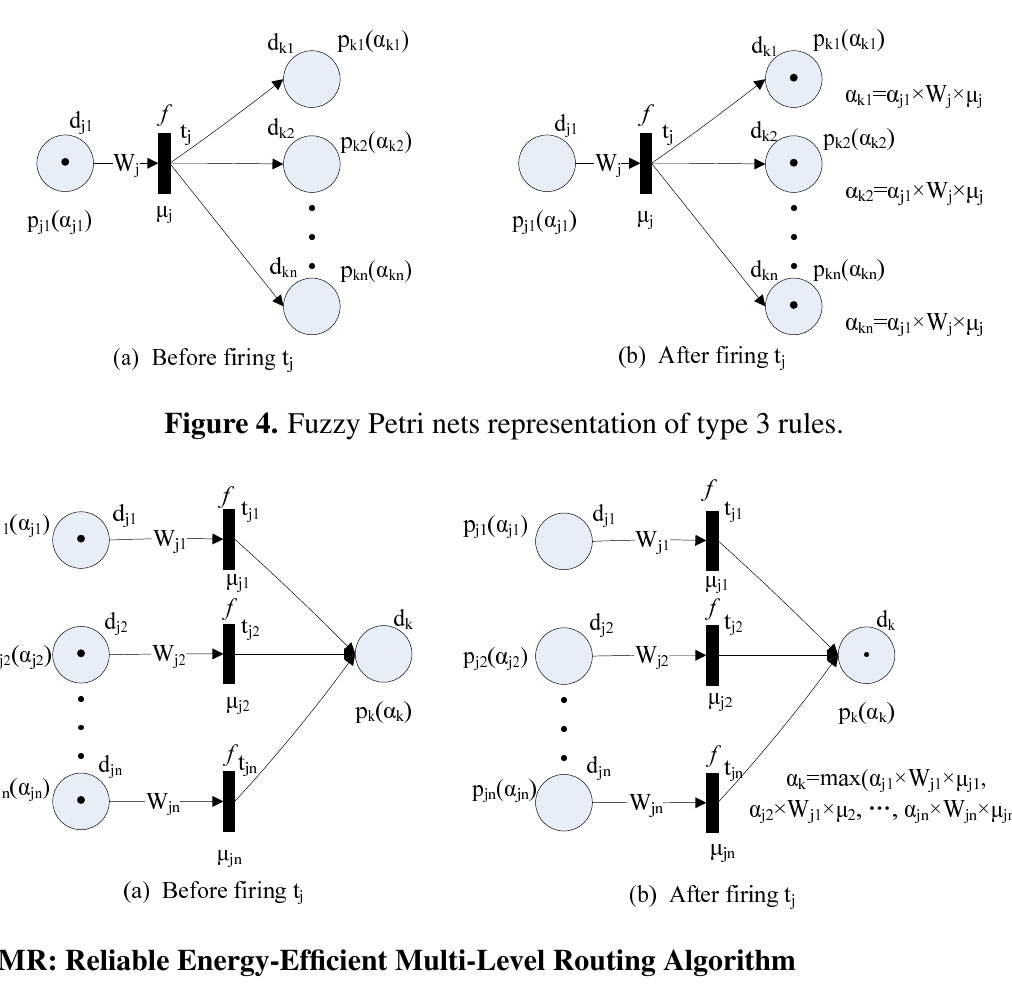
Figure 3. Fuzzy Petri nets representation of type 2 rules.